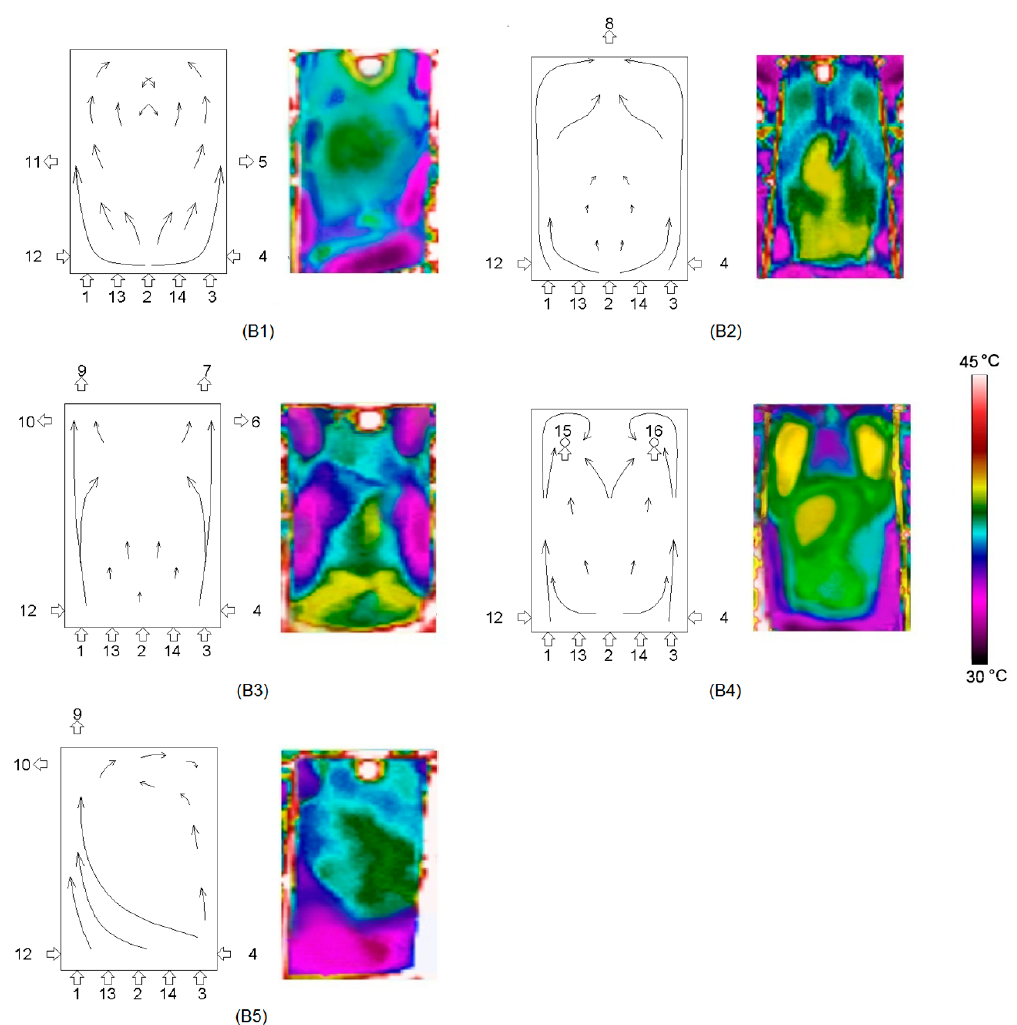
Figure A1. Diagrams of expected flow lines for group B configurations, alongside their respective thermographic images. The reader is referred to Table 2 for the description of each configuration.